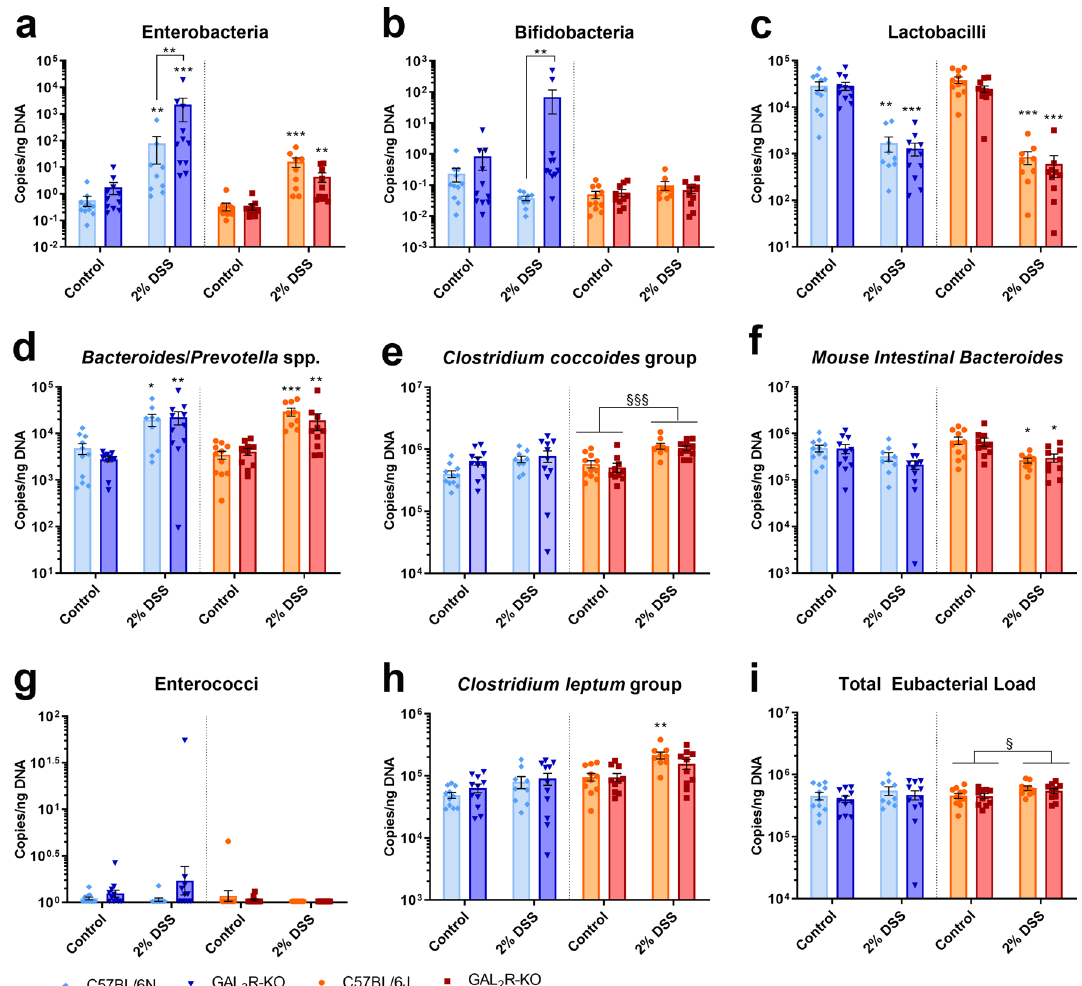
Figure 7. Changes of intestinal microbiota in GAL 3 R-KO, GAL 2 R-KO and corresponding WT mice following colitis induction with 2% DSS. Cecal contents were analyzed for main commensal bacterial groups, including enterobacteria ( a ), bifidobacteria ( b ), lactobacilli ( c ), Bacteroides/Prevotella spp. ( d ), members of the Clostridium coccoides group ( e ), Mouse Intestinal Bacteroides ( f ), enterococci ( g ), members of the Clostridium leptum group (H) and the total eubacterial load ( i ). Data represent means ± SEM. n = 9–11. Data were analyzed by two-way ANOVA, followed by Tukey’s test (main effect treatment: § p < 0.05; §§§ p < 0.001) or by Kruskal–Wallis test followed by Mann–Whitney U test. * p < 0.5; ** p < 0.01; *** p < 0.001 versus corresponding controls or as